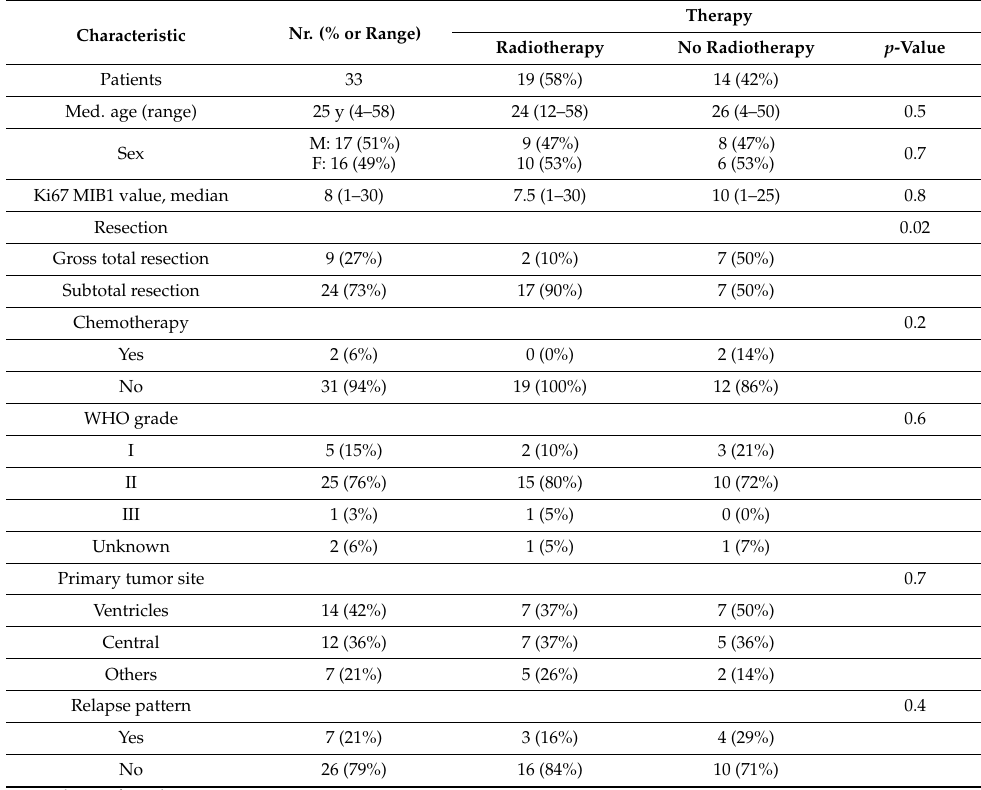
Table 1. Treatment characteristics and postoperative